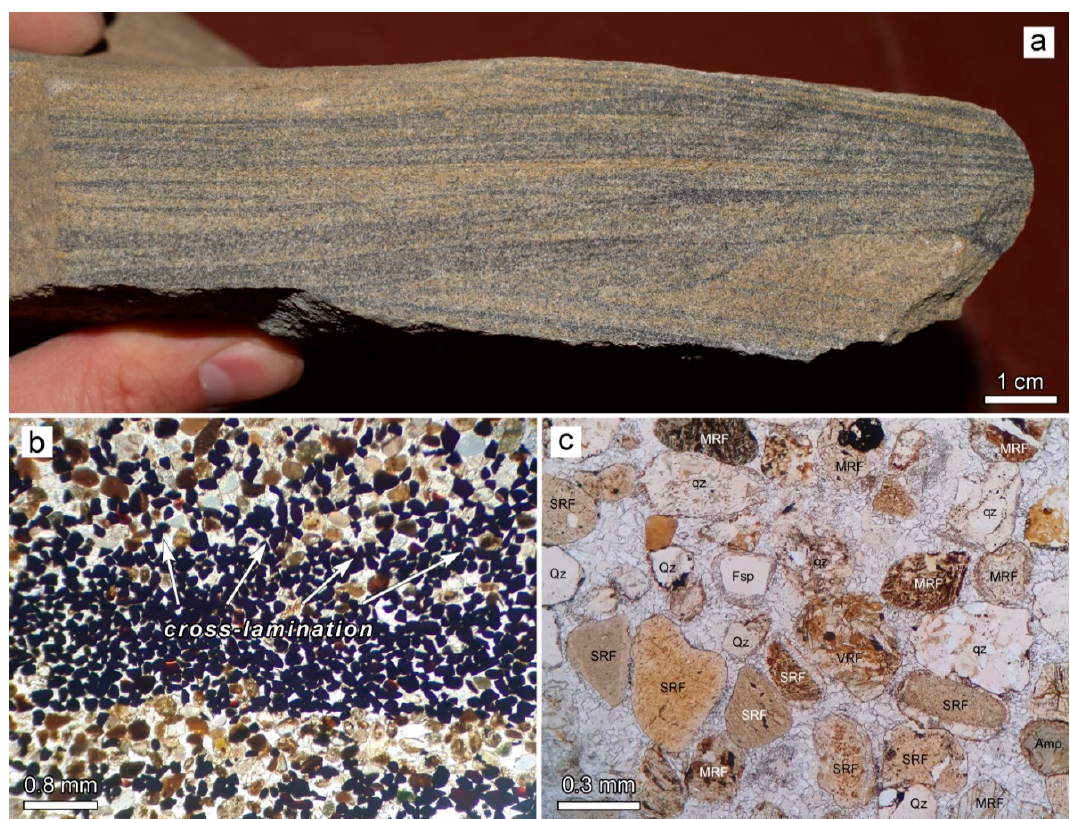
Figure 3. Hand size sample of chromite-rich sandstone from Sabantuy paleoplacer ( a ); ( b ) photomicrograph of chromitolite layer with cross-lamination texture (plane polarized light); ( c ) photomicrograph of the clastic texture of underlying sandstones (plane polarized light). Amp—amphibole, Fsp—feldspar, MRF—fragments of metamorphic rock, Qz—quartz, qz—quartzite, SRF—fragments of sedimentary rock and VRF—fragments of volcanic rock.